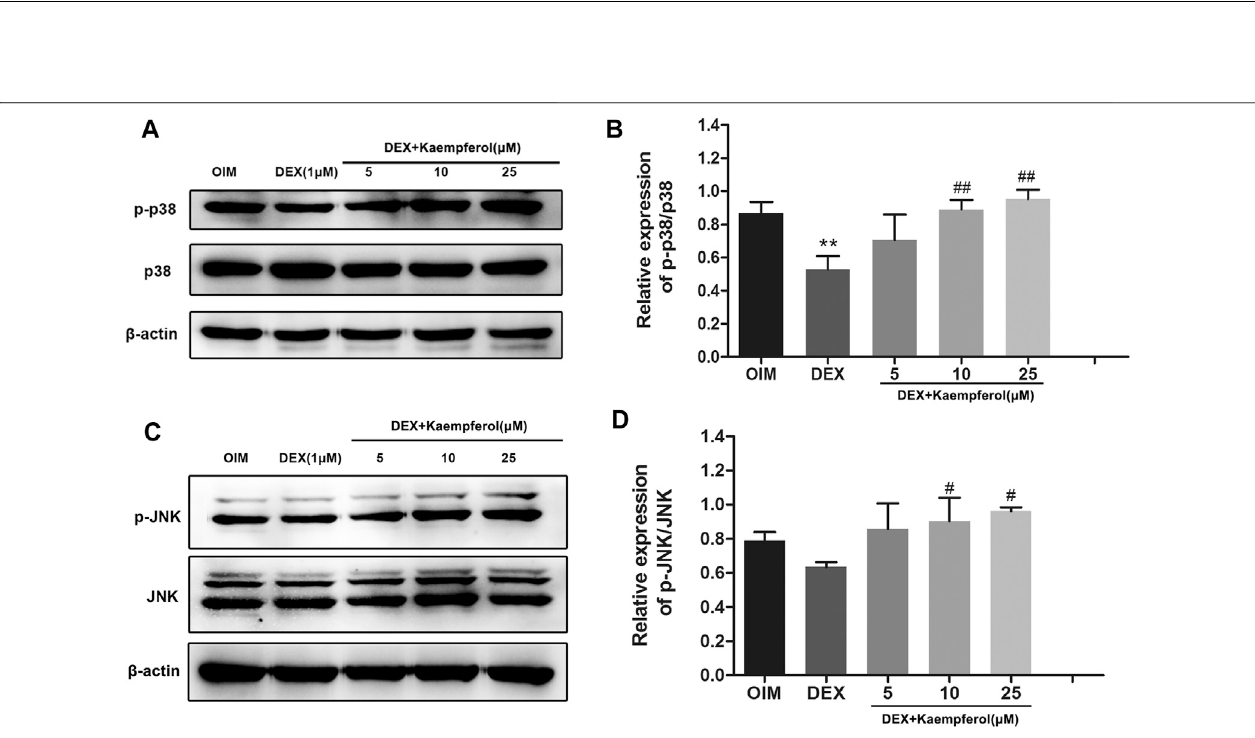
Frontiers in Pharmacology |